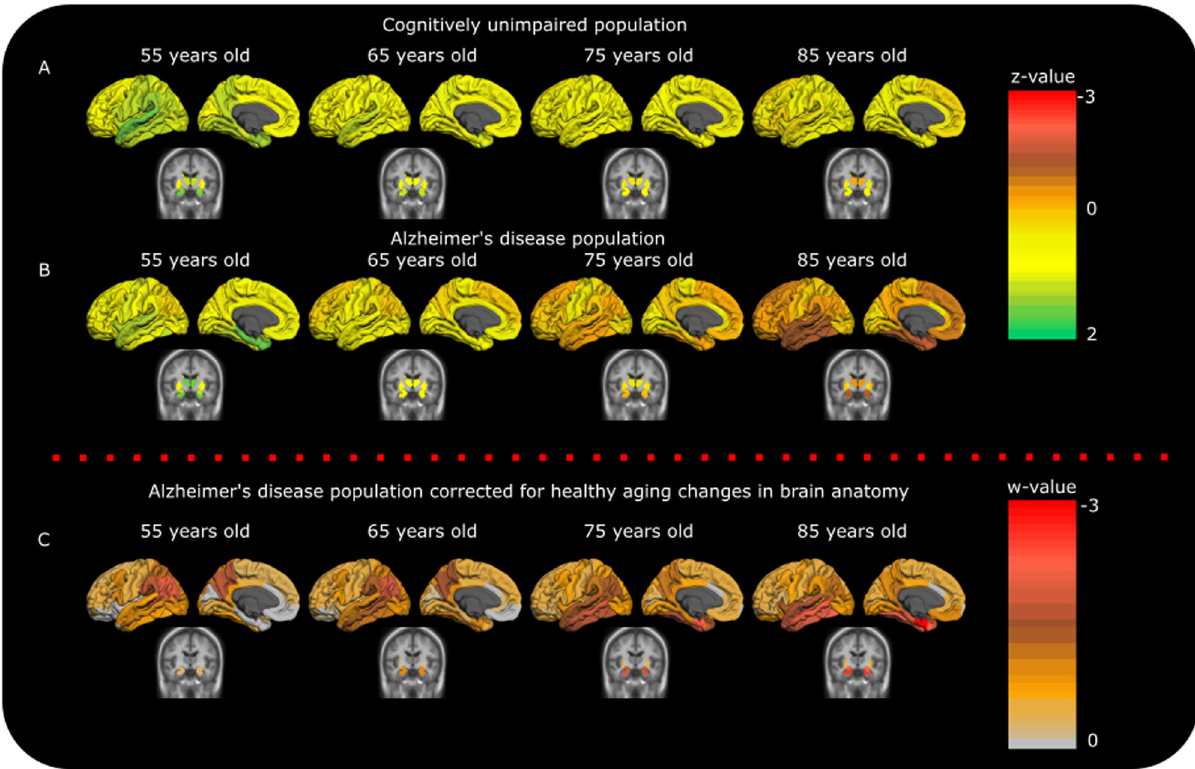
Fig.1|AtrophyatpopulationlevelintheCUandADgroups. Forthecalculation of cognitively unimpaired (CU) and Alzheimer ’ s disease (AD) atrophy patterns